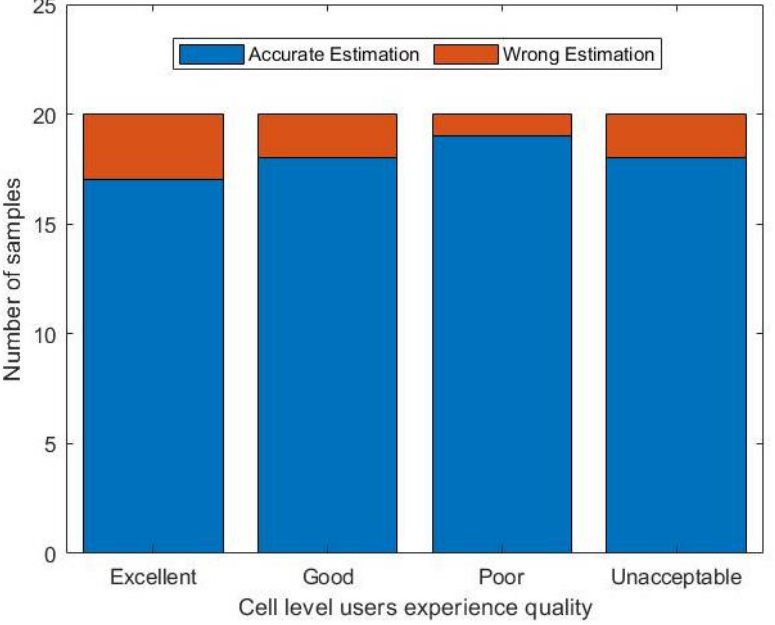
Figure 9. Statistical results for cell-level service perception evaluation.